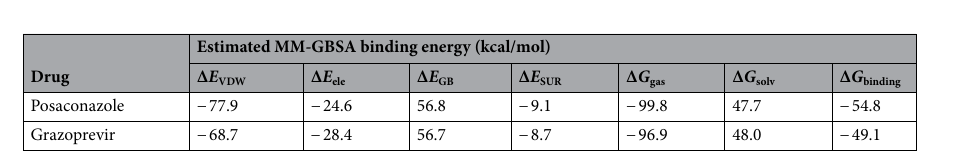
Table 2. MM-GBSA binding energies decomposition for the top two investigated drugs in complex with SARS-CoV-2 helicase through the MD course of 100 ns.